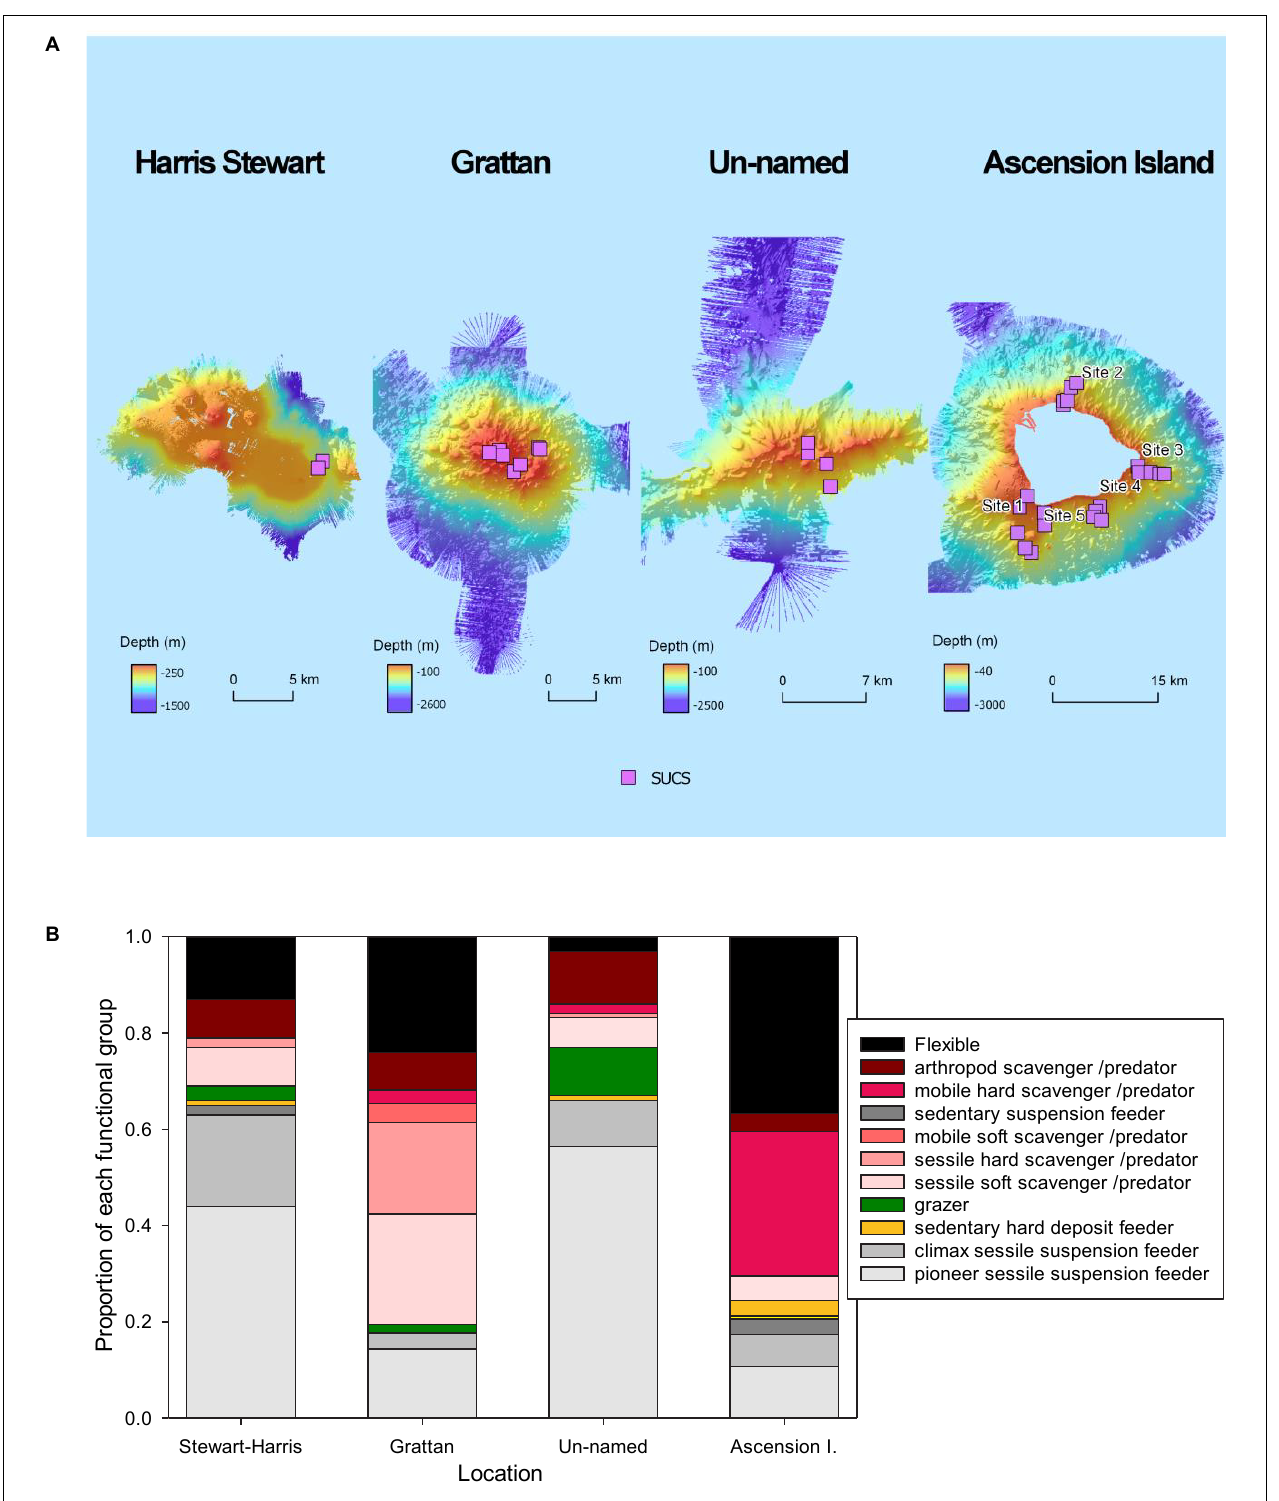
FIGURE 2 | (A) The expeditions of RRS James Clark Ross in 2015 and 2017 were the first to map the seabed around Ascension and it’s EEZ seamounts. The pink squares represent sites where imagery was collected using the Shelf Underwater Camera System (SUCS). (B) The proportion of individuals in images from each functional group per